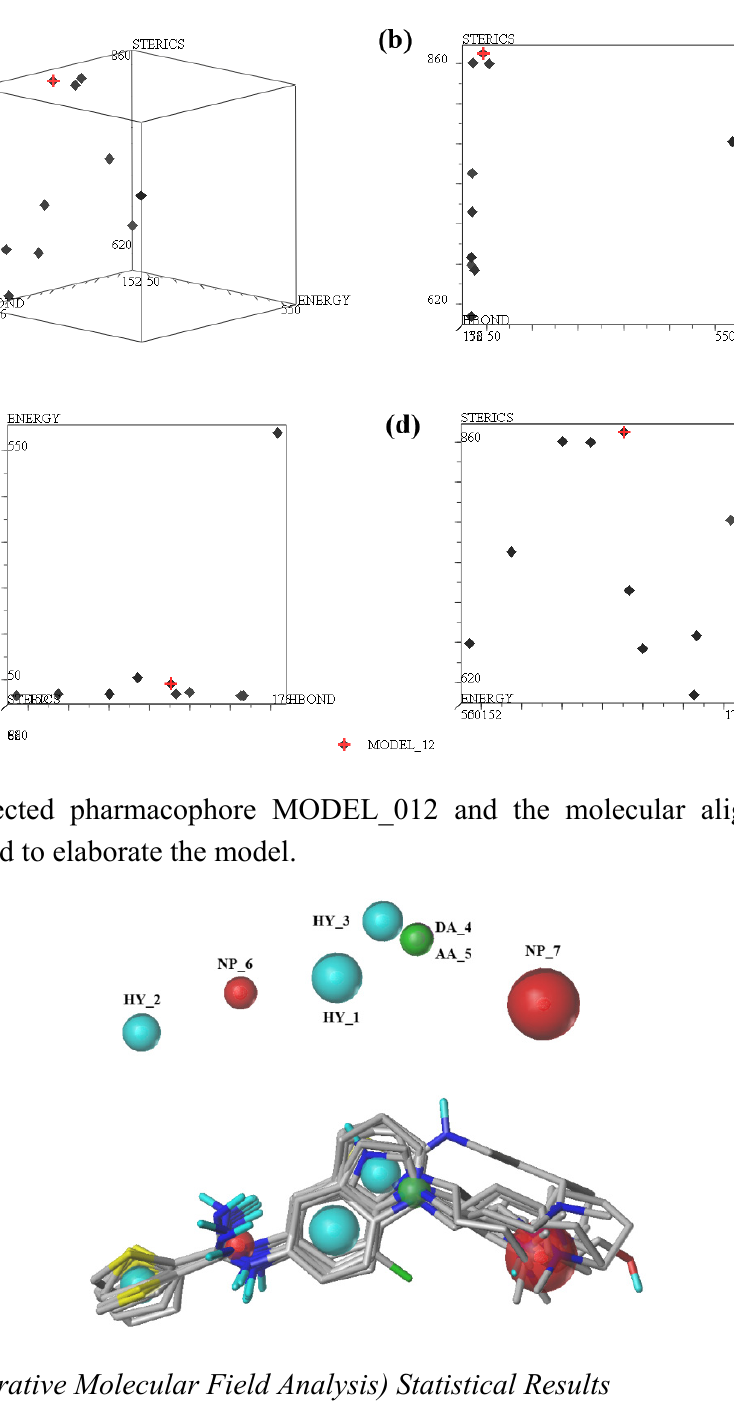
Figure 1. Plot of the STERICS, ENERGY and HBOND values for the models with the top ten Specificity values. ( a ) 3D plot; ( b ) plot of STERICS vs. ENERGY; ( c ) plot of ENERGY vs. HBOND; ( d ) plot of STERICS vs. HBOND. The red cross represents MODEL_12.